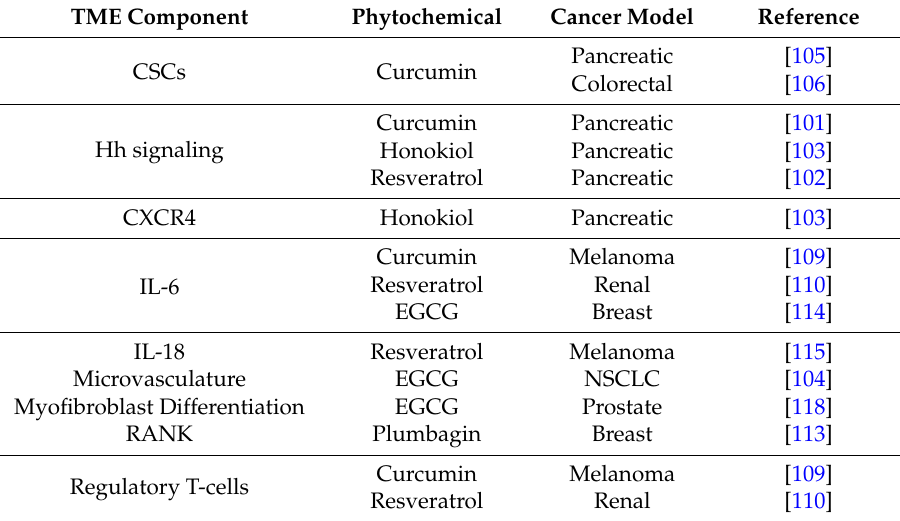
Table 2. Tumor microenvironment components affected by